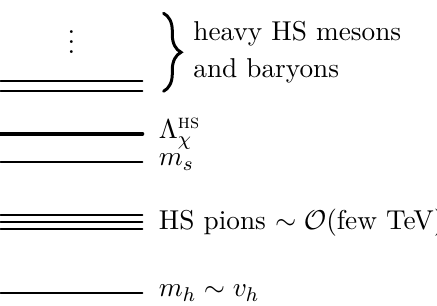
Figure 1 . Spectrum of the hidden sector states relative to the weak scale v h . In our analysis, we assume that the hidden-sector Higgs boson, s , is close to or above Λ hs it as a low-energy degree-of-freedom in our